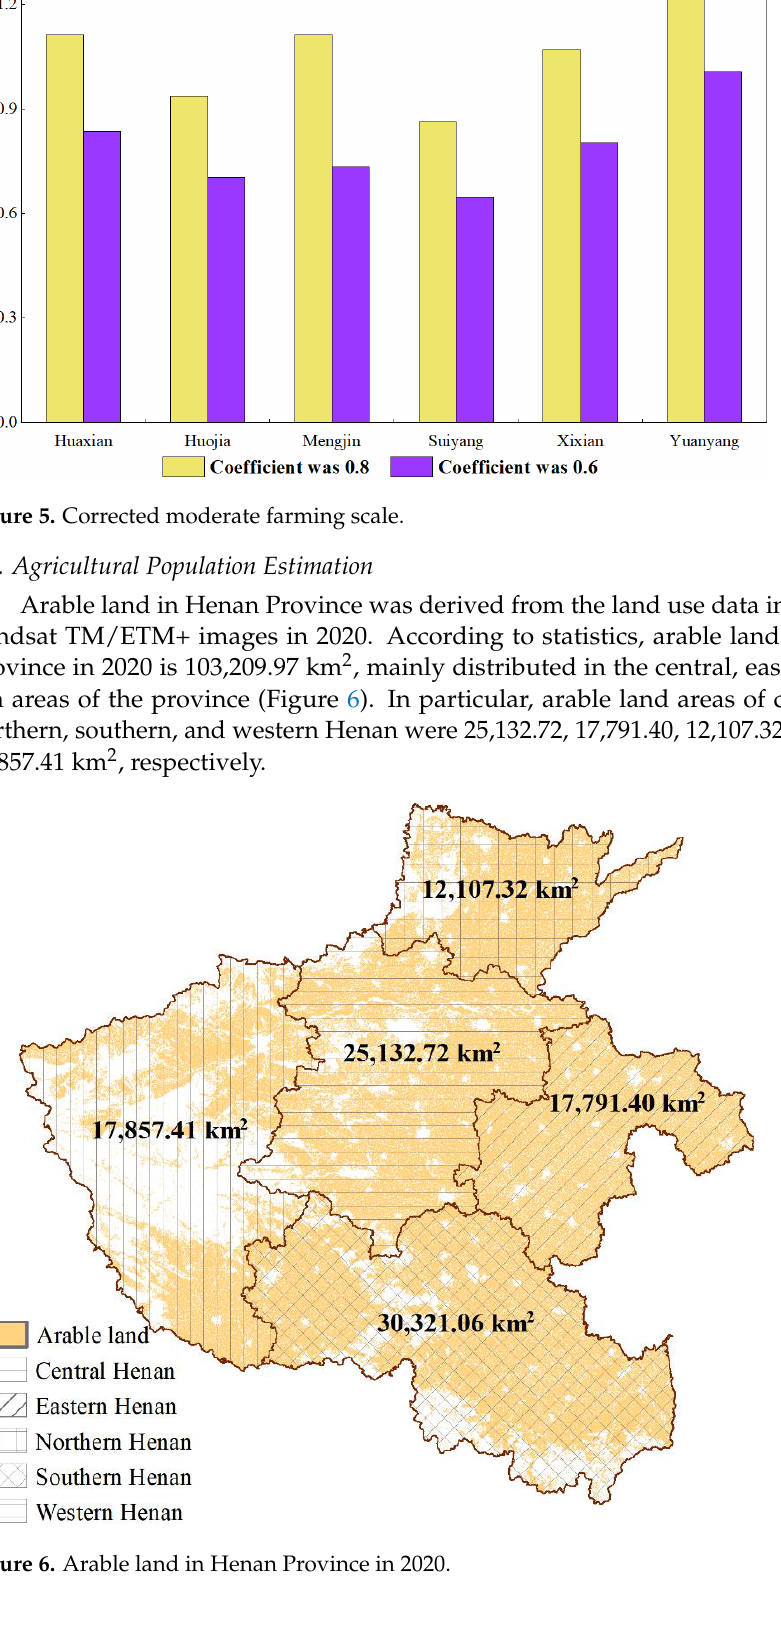
Figure 6. Arable land in Henan Province in